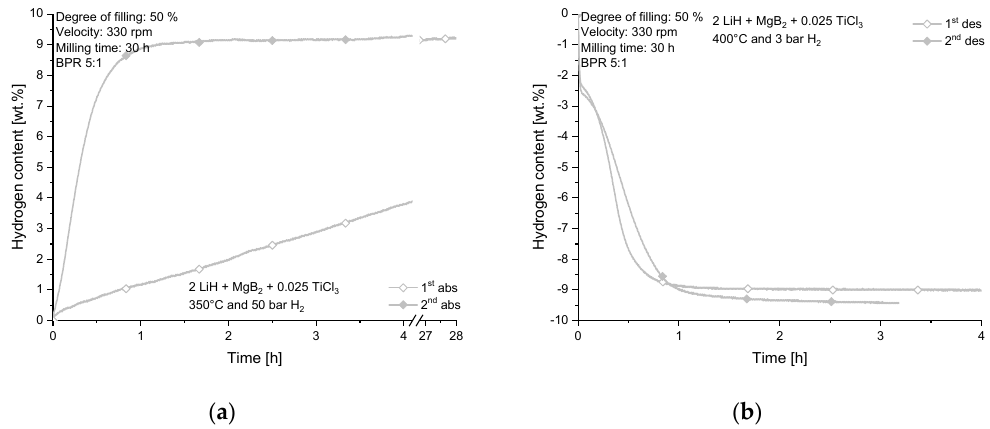
Figure 10. Hydrogen quantity against time for a powder sample milled for 30 h under 330 rpm with a 50% of filling and a BPR of 5:1 for ( a ) absorption and ( b ) desorption.